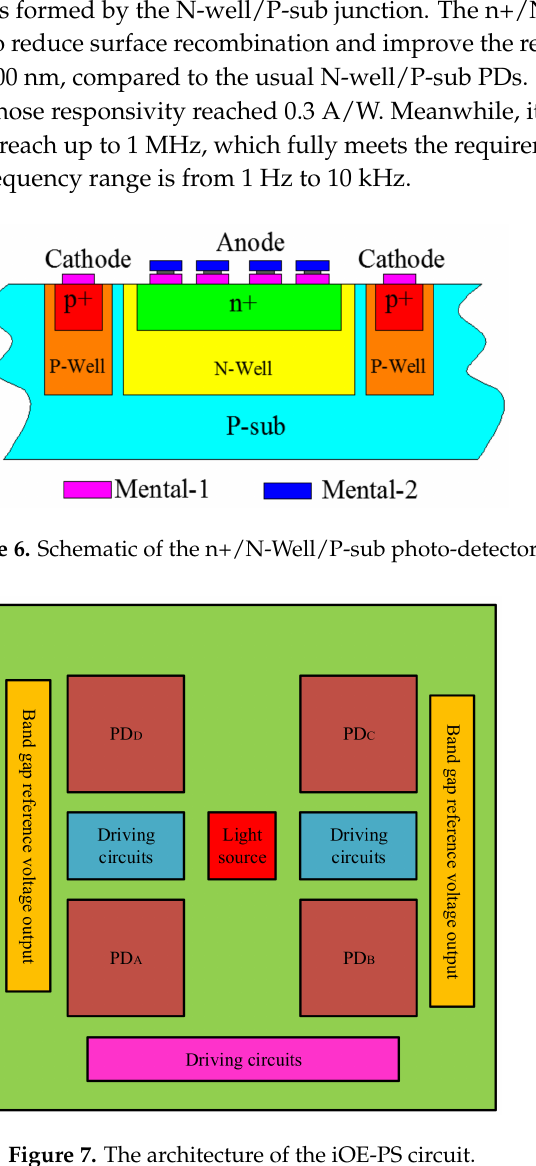
Figure 7. The architecture of the iOE-PS